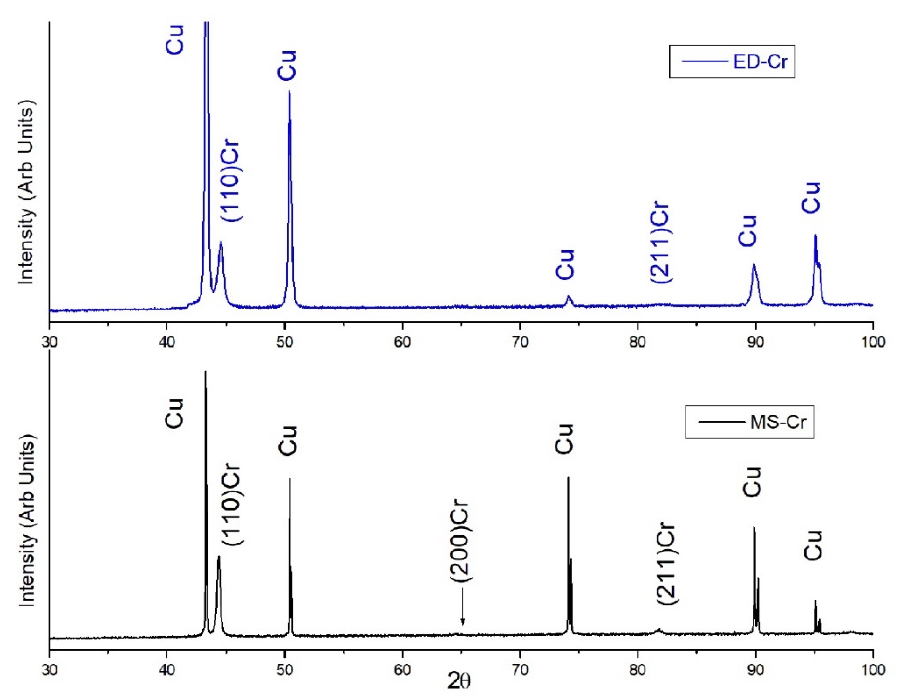
Figure 4. X-ray diffraction of the electrodeposited ED-Cr ( above ) and magnetron sputtered (MS-Cr ( below ) chromium coatings. Substrate (copper) diffraction peaks (copper) have also been indicated.